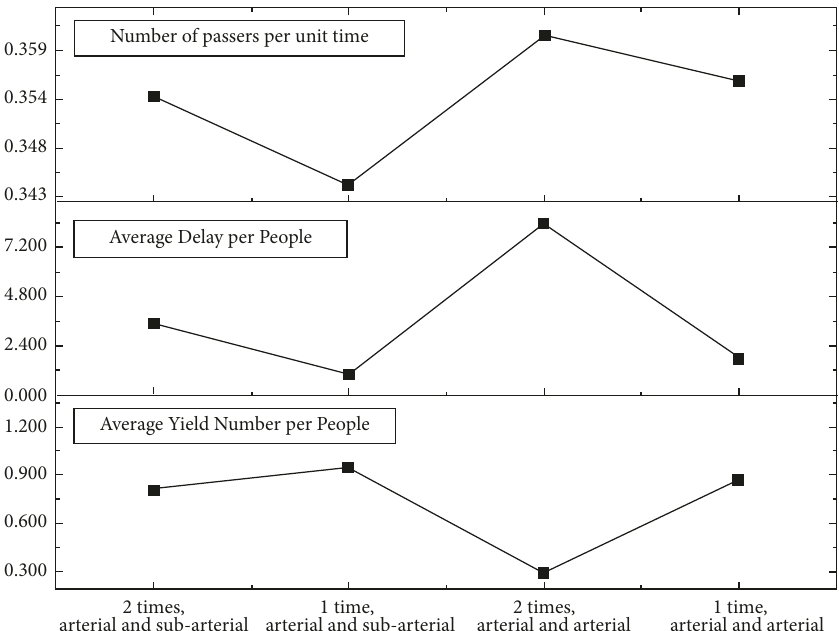
Figure 14: Variation of the standard deviation of three efficiency evaluation indices.